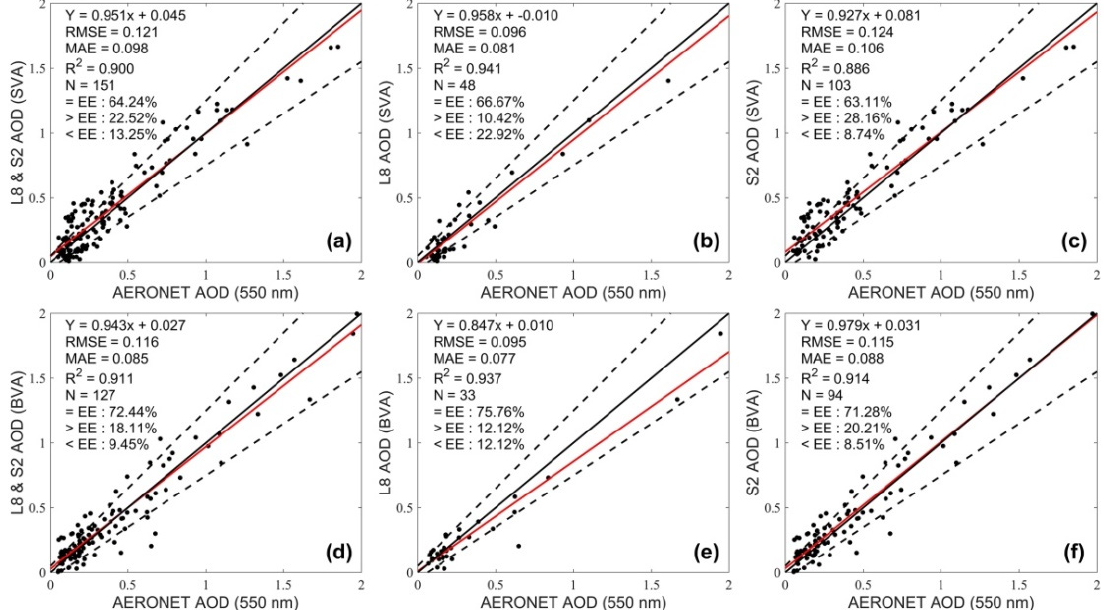
Figure 6. Comparison of the AODs over ( a – c ) sparsely vegetated areas (SVA) and ( d – f ) barely non-vegetated areas (BVA) for Landsat-8 and Sentinel-2 against AERONET AOD measurements.